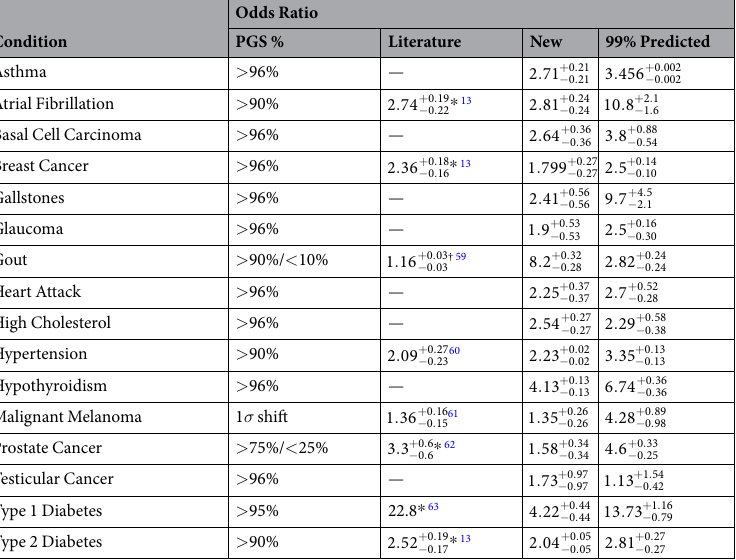
Table 1. Comparison of best known odds ratios in the literature (Literature) to the odds ratios calculated from UK BioBank data presented here (New). Comparison was either made at the largest possible PGS common to the two sets, or using whatever definition of odds ratio was used in the literature (PGS %). Additionally we indicate what we predict the odds ratio will be for those with 99% scores or above (99% Predicted